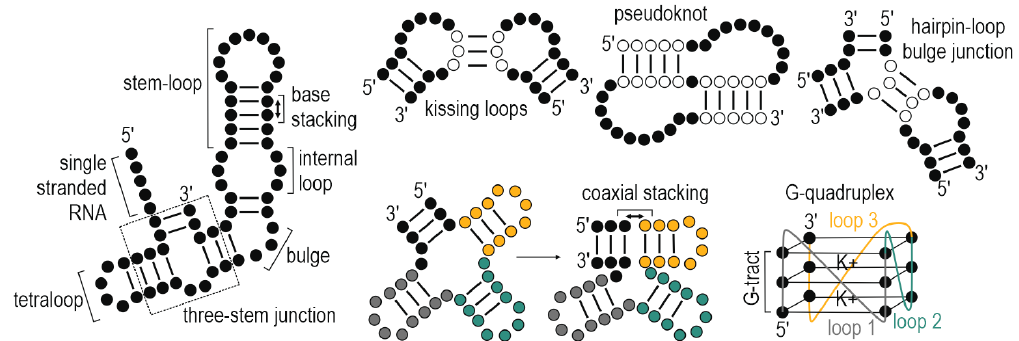
Figure 2. Schematic presentation of common RNA structural motifs present in secondary and tertiary structures. More details in the main text. Ribonucleotide residues are marked with black and white dots; hydrogen bonds are marked with short lines; base stacking is marked with a double arrow; K+, potassium ion.